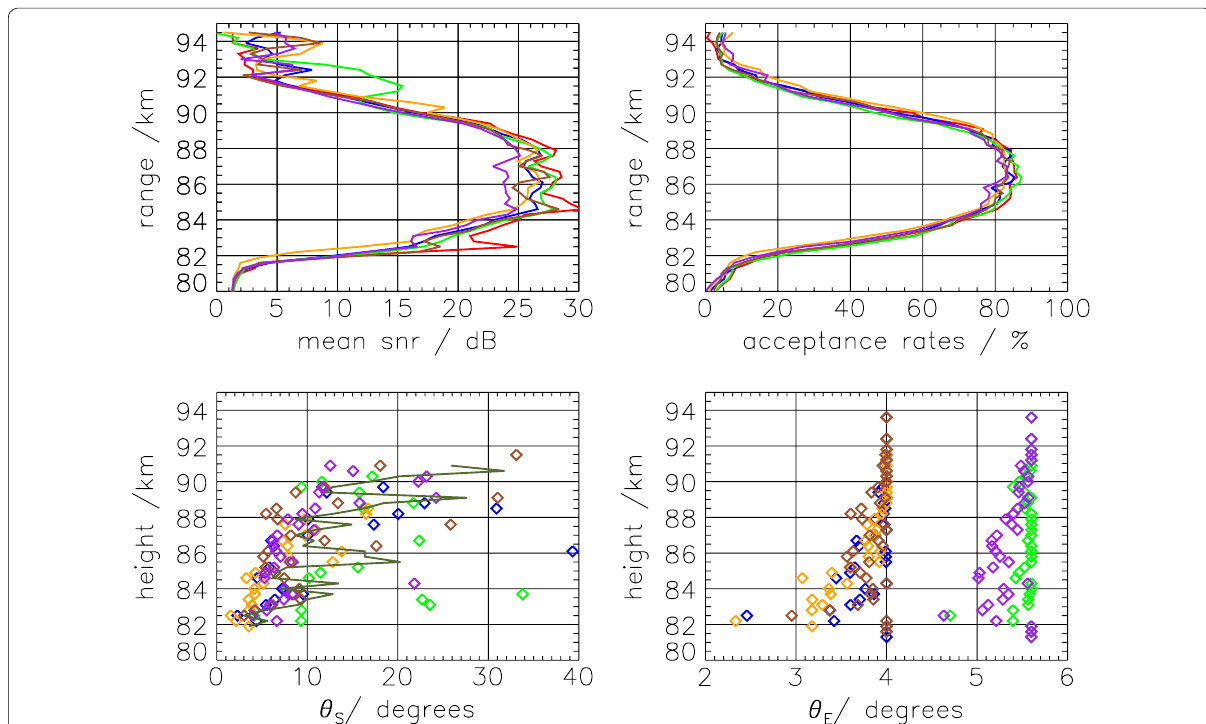
Fig. 2 Mean SNR for each of the beams for the entire observational period (top left), the radial velocity acceptance rates for each range for the six beams using a 3-dB acceptance criterion (top right), the scattering angle θ s calculated from each of the off-zenith beams and the mean of these (in olive, centre) (bottom left), and the mean effective beam angle θ E for each of the beams (bottom right). The 3-dB acceptance criterion has also been applied to calculate θ s and θ E . The beams are colour coded as: vertical, red; north-west, blue; north, green; north-east, orange; south-west, brown; and west,